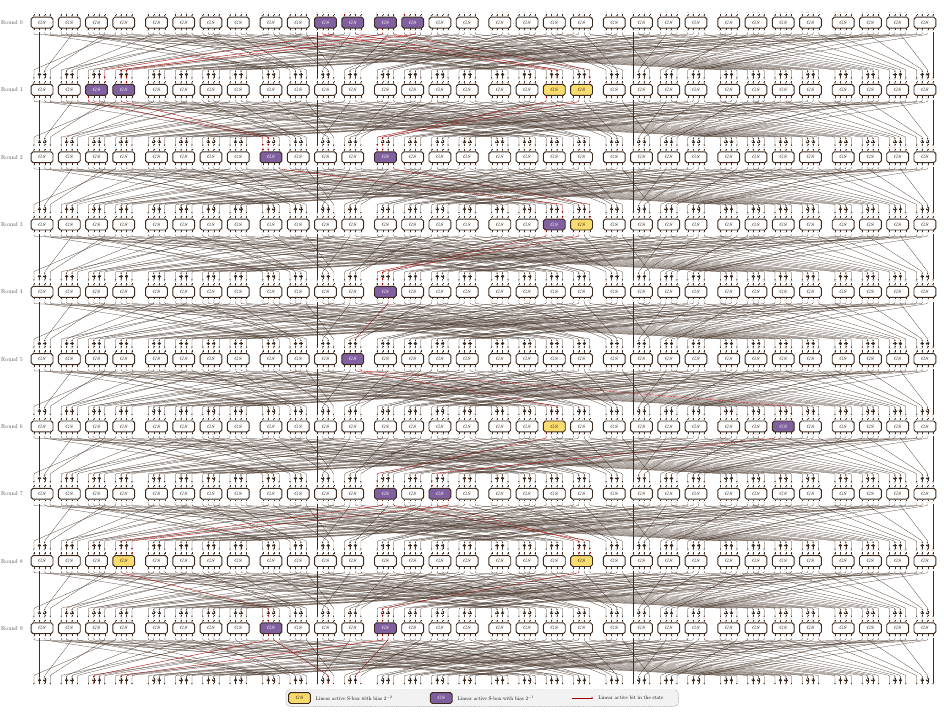
Figure 6: 10-round characteristic with c = 2 − 28 in the approximation concerning HyENA .